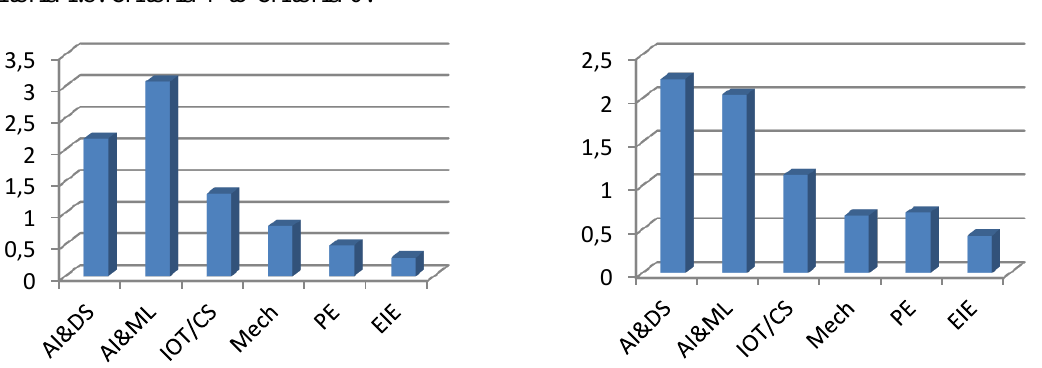
Figure 1: Weights of alternatives with respect to C 1